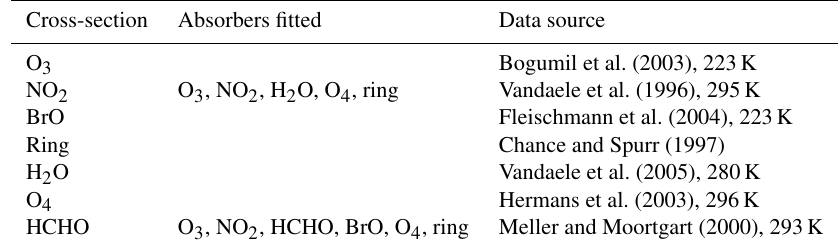
Table 1. Cross-section data references and absorbers fitted in the HCHO and NO 2 windows.